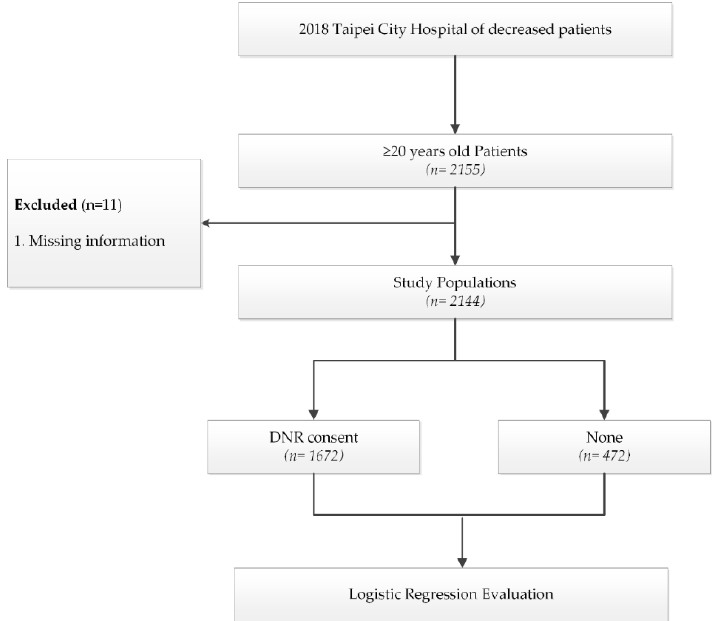
Figure 1. Patient enrollment and exclusion.